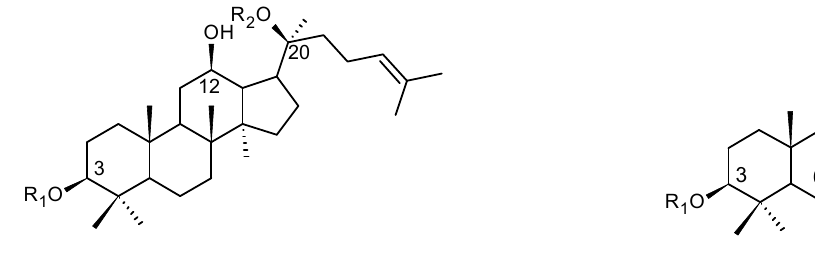
Figure 1. Major classes of Ginsenoside.